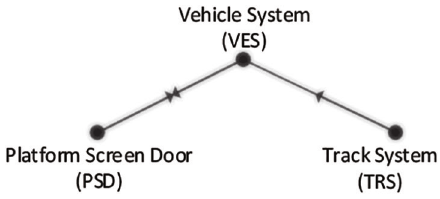
Figure 4. Example of network